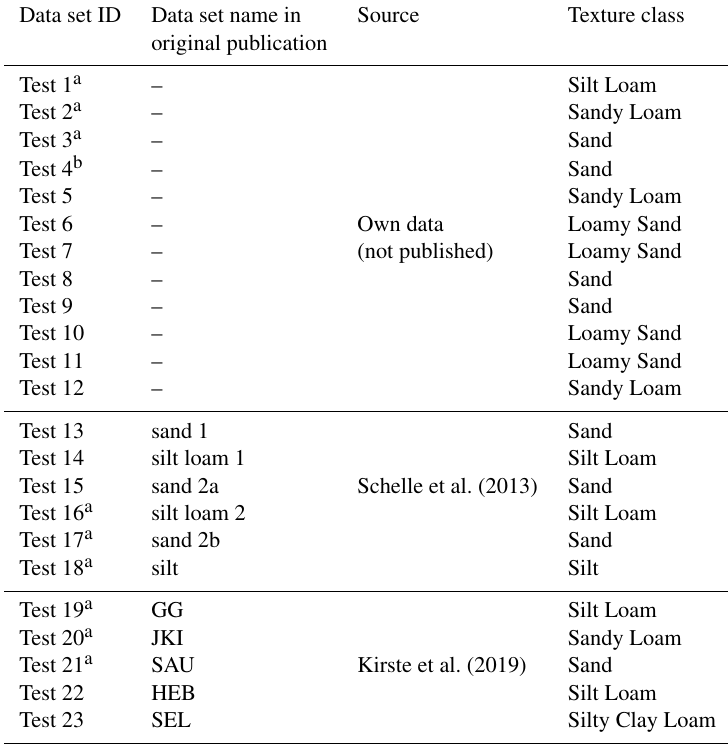
Table 4. Test data sets used to test the conductivity